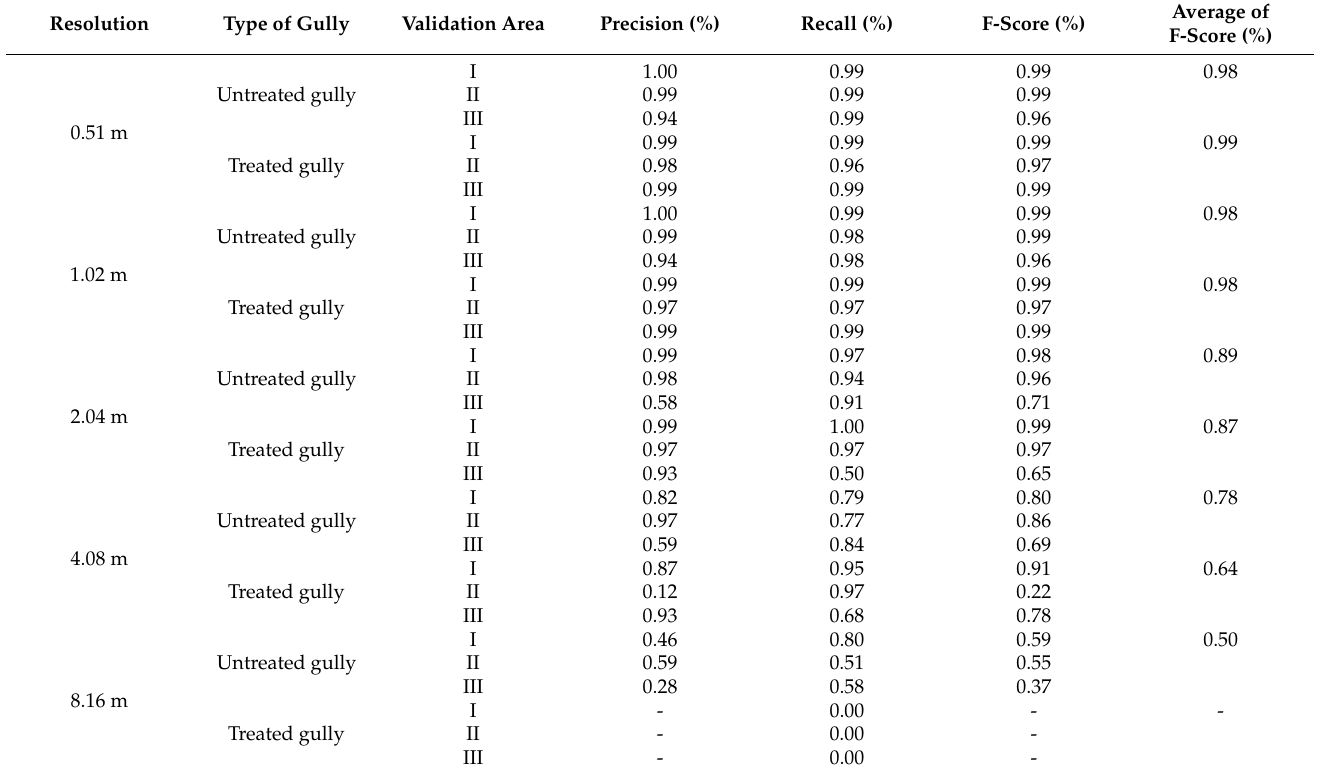
Table 5. Accuracy evaluation of interpretation of untreated gullies and treated